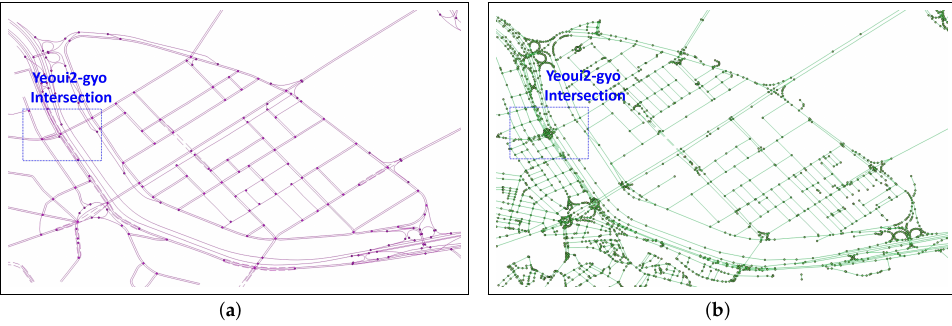
Figure 3. NLM and ORN graph representation of Yeoui-do roads: ( a ) NLM graph and ( b ) (pruned) ORN